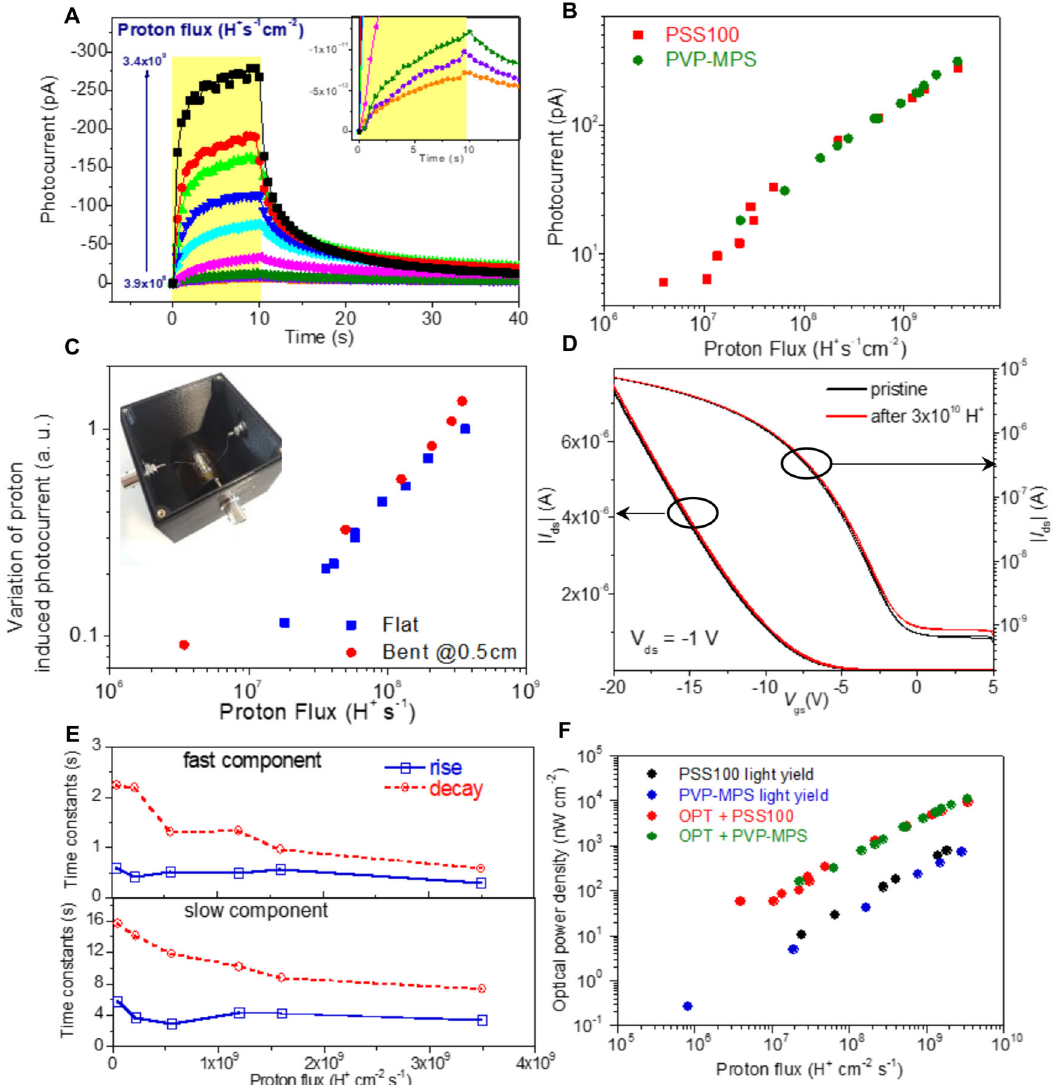
Fig. 4 Proton detection response of fully organic fl exible indirect detectors. a Dynamic response of a detector with a PSS100-based scintillator for different impinging proton fl uxes. The inset expands the lower fl uxes. Exposure time window: t exp = 10 s; OPT working polarization: V ds = V g = − 1 V. b Values of the photocurrent normalized to the dark current as a function of the proton fl ux (red squares for PSS100 and green circles for PVP-MPS scintillators). t exp = 10 s. c Variation of proton-induced photocurrent normalized by the maximum value recorded for the detector in fl at con fi guration vs. the proton fl ux impinging onto the device, for the fl at (blue squares) and the bent (red circles) samples. The inset shows the experimental set-up used for the characterization of the detector during bending. d Typical transfer curves of the detector with PVP-MPS-based scintillator before and after exposure under irradiation at 6.5 × 10 7 H + s − 1 cm − 2 for t exp = 50 min. Forward and reverse curves are reported. e Characteristic τ of the signal formation and decay as a function of the proton fl ux. f Optical power density generated by the stand-alone scintillators (black and blue dots) as a function of the proton fl ux and by the indirect detector (OPT coupled with the scintillator) under proton irradiation (red and green dots) expressed in terms of equivalent optical power density as a function of the proton fl The dynamic photocurrent measurements on our organic devices (Fig. 5a, b, experimental curves) show two distinctive features: